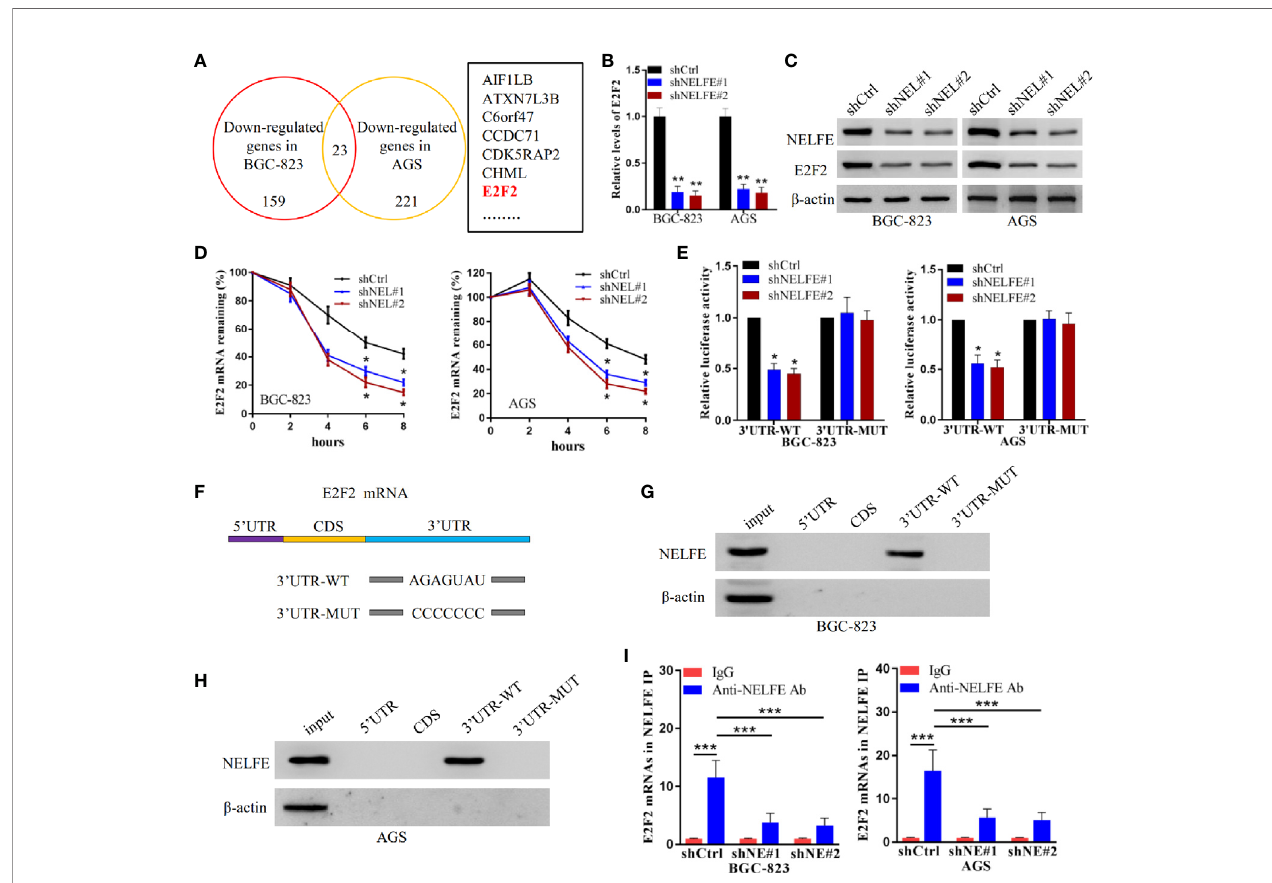
FIGURE 4 | E2F2 was regulated by NELFE in human gastric cancer cells. (A) Graph of 23 genes whose expression decreased in BGC-823 and AGS cells after NELFE knockdown, as demonstrated by RNA sequencing. (B, C) The expression levels of E2F2 were detected by qRT-PCR and western blotting when NELFE was knocked down. (D) The mRNA decay rate of E2F2 in NELFE-knockdown BGC-823 and AGS cells was detected by the mRNA decay assay. (E) Change in the E2F2 3 ’ UTR luciferase reporter activity with the consumption of NELFE. (F) Schematic depiction of the E2F2 5 ’ UTR, CDS and 3 ’ UTR, as well as the biotinylated RNAs synthesized for use in biotin pulldown analysis. The interaction of NELFE protein with each biotinylated E2F2 5 ’ UTR, CDS, wild-type 3 ’ UTR, and mut-type 3 ’ UTR RNA segment was analyzed by western blotting in BGC-823 (G) and AGS (H) cells, with b -actin as input control. (I) Enrichment of E2F2 mRNA was conducted by the mRNP immunoprecipitation assay. *P < 0.05, **P < 0.01, ***P <